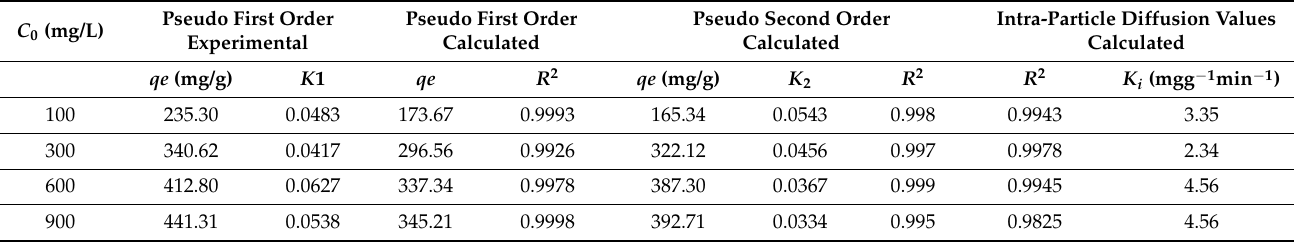
Figure 5. Pseudo first-order plot ( A ), pseudo second-order plot ( B ) and intra-particle diffusion plot ( C ) for Pb(II) adsorption onto chemically modified SM. Table 3. Pseudo first-order, pseudo second-order and intra-particle diffusion values for Pb(II) adsorption onto chemically modified